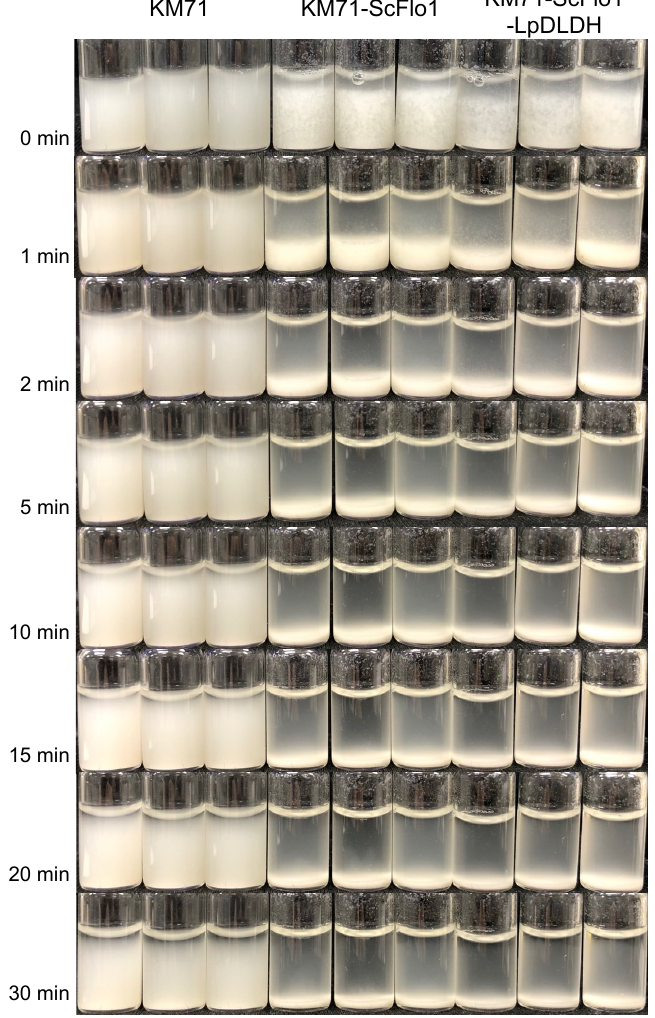
Figure 1. The flocculation phenotypes of engineered strains generated in this study. P. pastoris KM71, KM71-ScFlo1, and KM71-ScFlo1-LpDLDH were cultivated in MGYH-glu medium overnight at 30 °C at 250 rpm. One milliliter aliquots of the overnight cultures were transferred to 1.5 mL glass vials. The experiments were performed in biological triplicate.